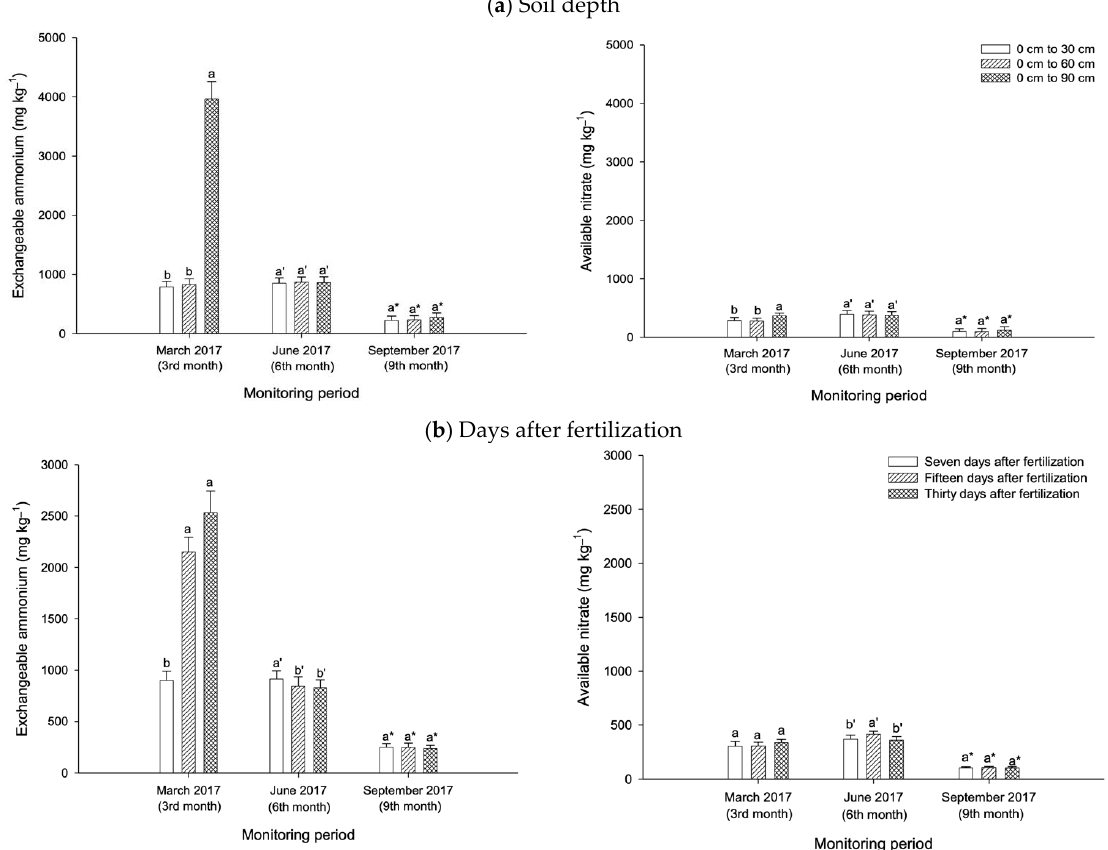
Figure 11. Mean retention of exchangeable ammonium and available nitrate from peat soils cultivated with pineapple ( a ) according to soil depth and ( b ) after fertilization with overall treatments (T1 to T6). Error bars indicate the standard error of the mean (n = 486). Means with different letters are significantly different using Tukey’s test with p ≤ 0.05. CZ: clinoptilolite zeolite. Letters without primes, single primes, and asterisks represent nitrate retention at the end of the wet season. Compared with the fertilization period (Figure 10c), the peat soils with CZ (T1) demonstrated a higher exchangeable ammonium retention at day thirty after fertilization during the early vegetative phase of the pineapple plants. At six months after planting the pineapple suckers, T2 consistently improved exchangeable ammonium retention, regardless of the fertilization period, compared with NPK fertilization (T5) (Figure 10c). Irrespective of the fertilization period, all the treatments with CZ were not effective in improving exchangeable ammonium relative to other treatments, including the controls (T5 and T6),